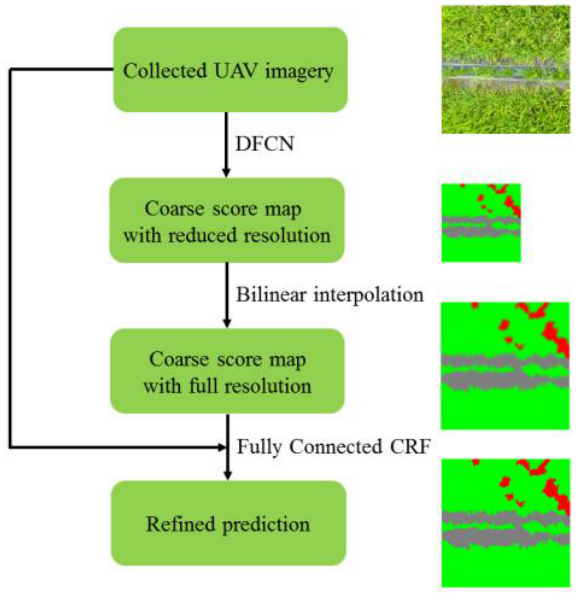
Figure 5. The work-flow of our methodology.